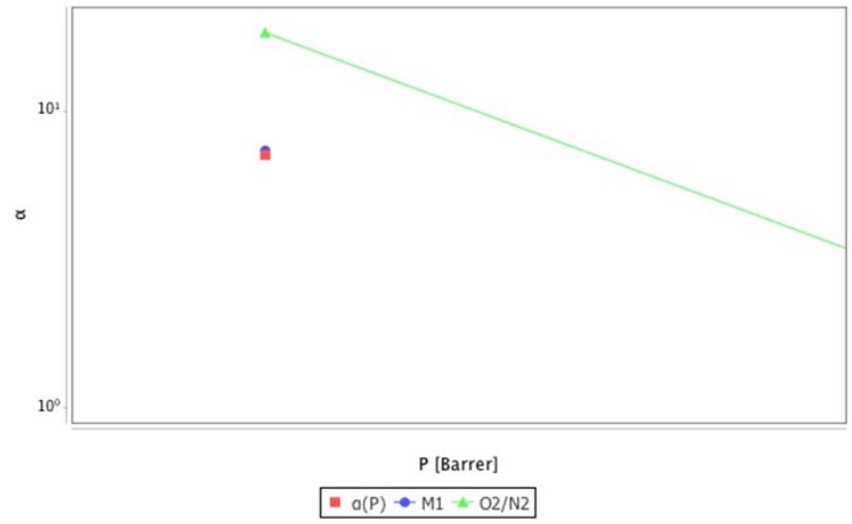
Table 4. Experimental and theoretical MOT-predicted data for the zeolite 4A-HBPI mixed-matrix